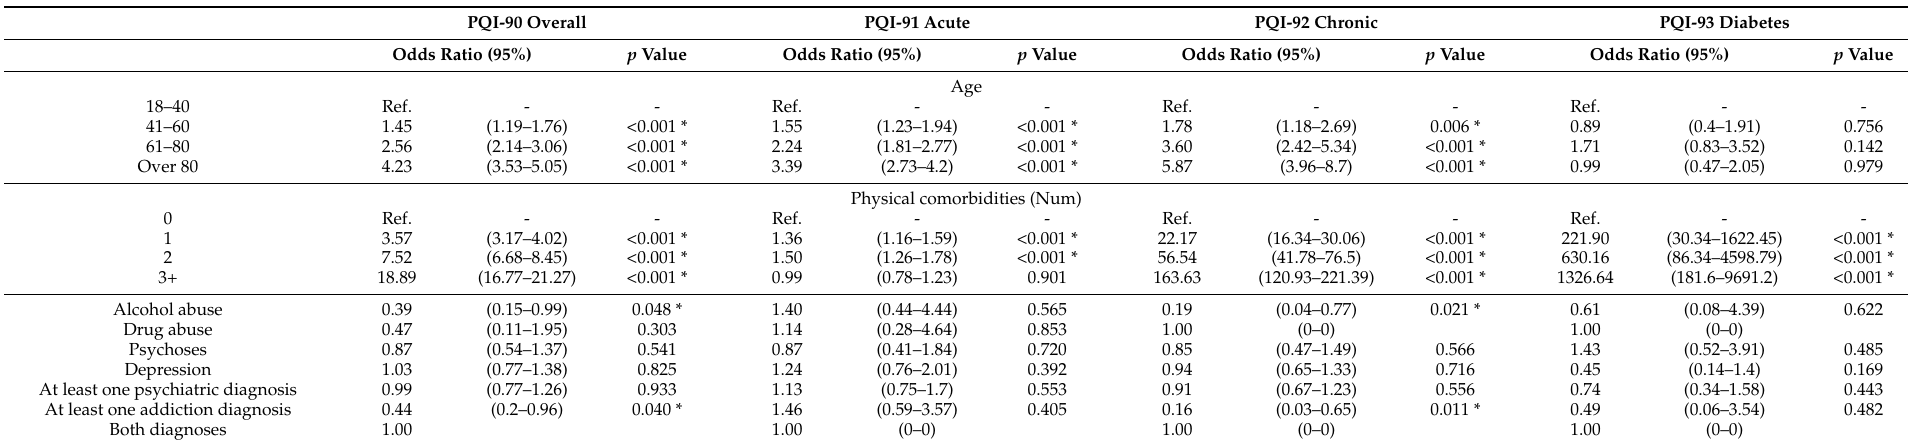
Table 5. Logistic regression for PQI in